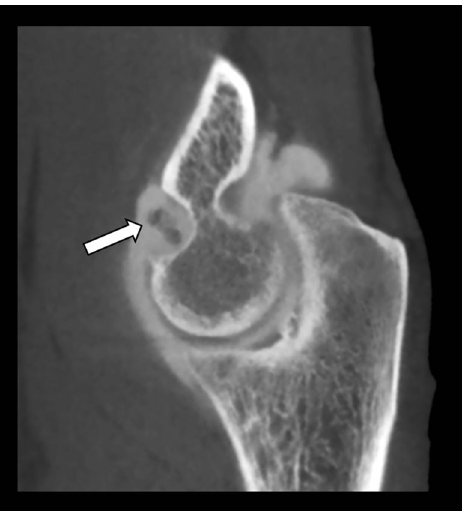
Fig. 11 Intra-articular loose bodies. Sagittal CBCT-A reformatted image shows the presence of intra-articular loose bodies (arrow)